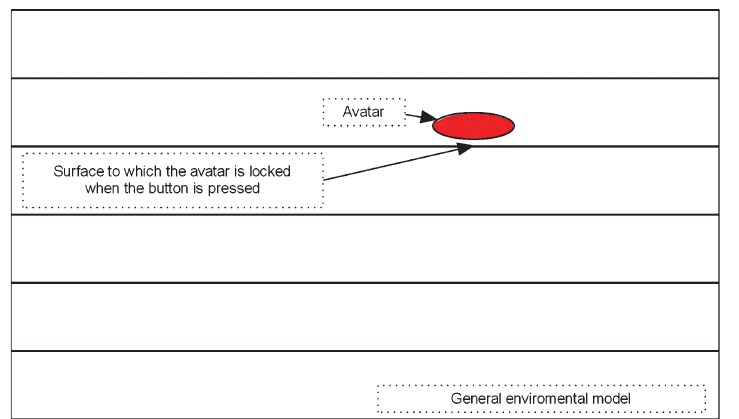
Fig. 9. Estimating the stiffness distribution within a volume, the surgeon has the possibility of touching under the natural surface. In the system’s implementation the surgeon’s finger is represented by an avatar. The touching surface is set by a secondary control at different levels of the virtual